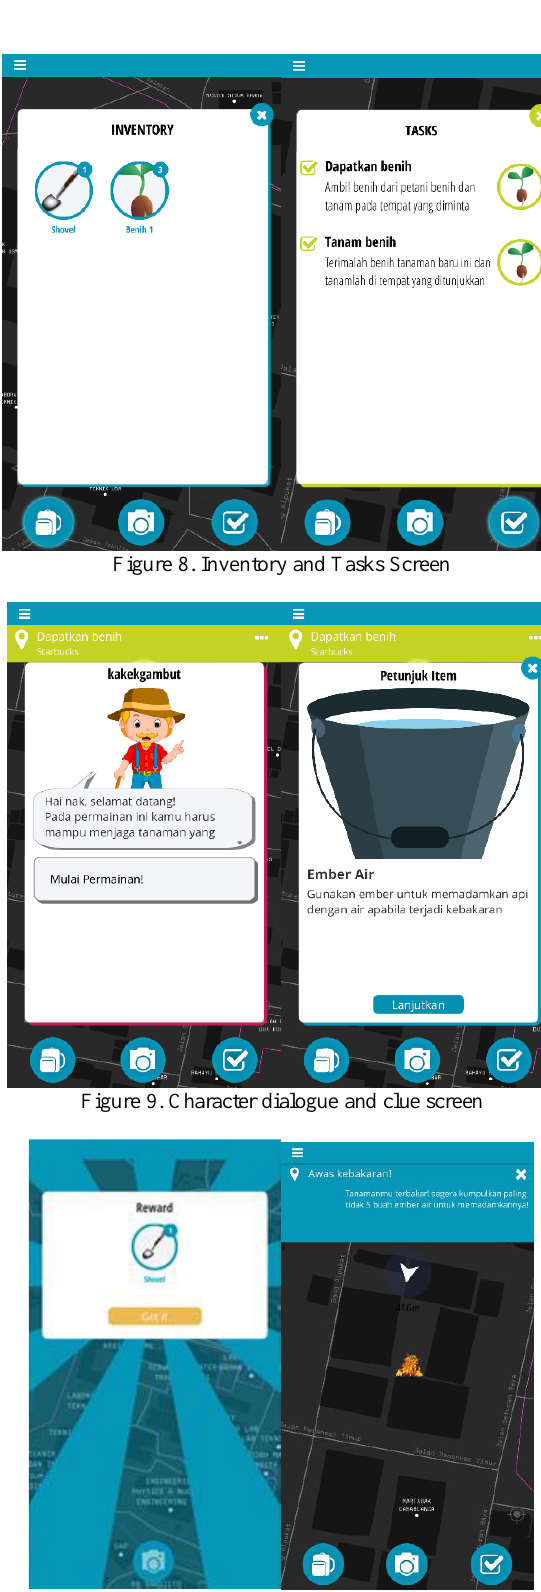
Figure 10. Reward and fire disaster